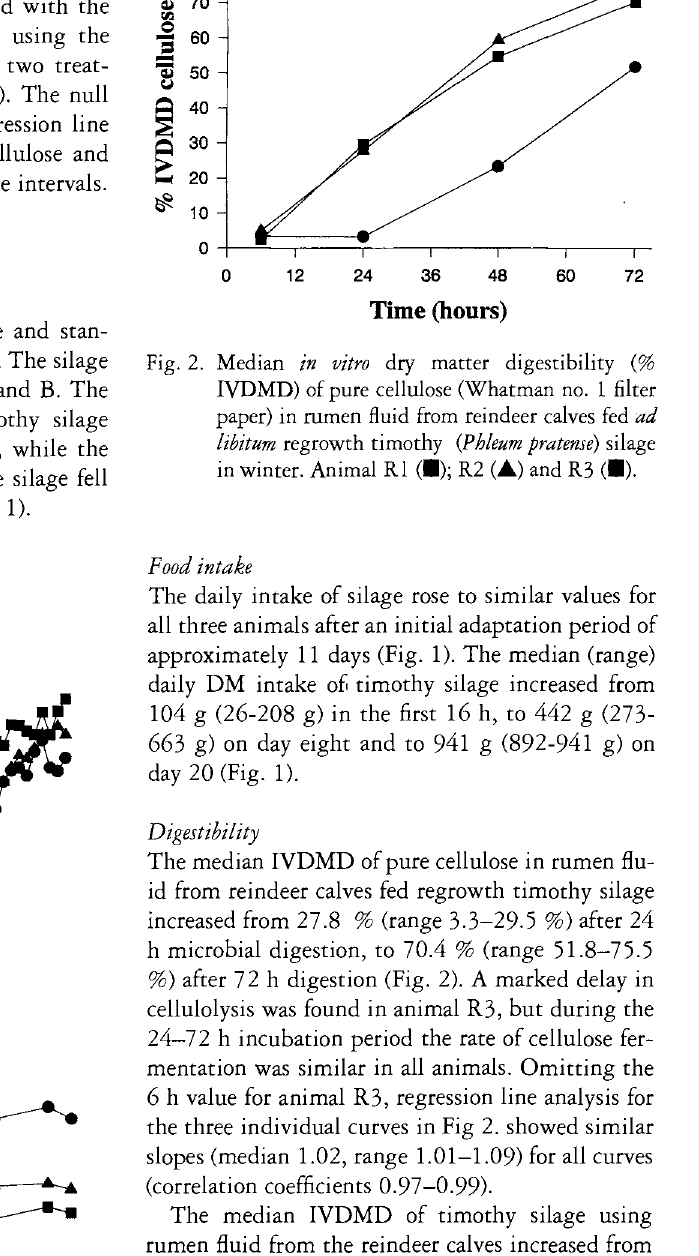
Fig. 1. Food intake and body mass in reindeer calves fed ad libitum regrowth timothy (Phleum pratense) silage. Animal Rl (•); R2 (•) and R3 (•).